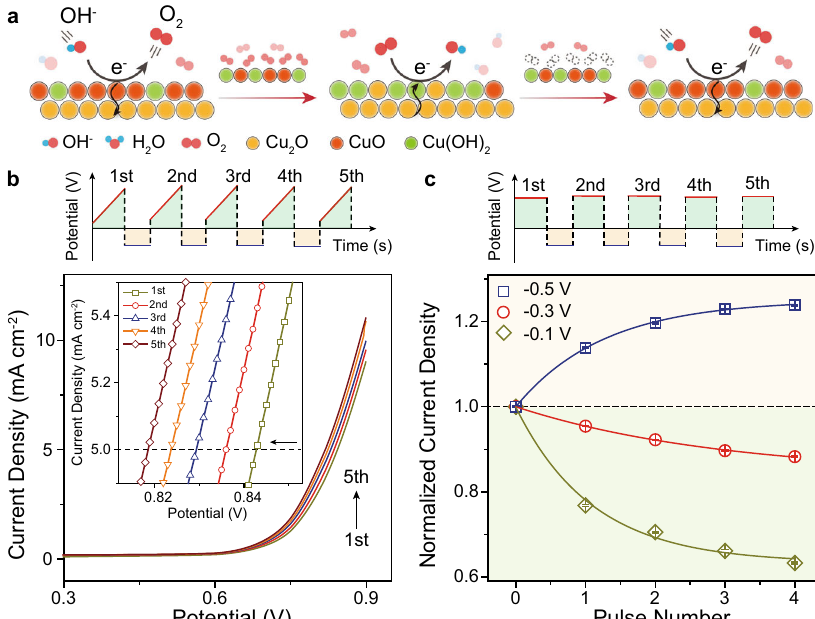
Fig. 5 Programmable potential scan strategy to eliminate accumulated interfacial dissolved oxygen at the EEIs. a Schematic illustration of reduction potential pulse accelerating interfacial oxygen species removed from the electrode surface. b Linear sweep voltammetry curves of Cu electrode combined with reduction potential multi-pulse ( − 0.50 V) in 0.10 M KOH solution at a scan rate of 0.01 V s − 1 . Inset shows cathodic shift of the oxygen evolution potential as consecutive reduction potential pulses ( − 0.50 V). c Mean chronoamperometry current density at 0.70 V as a function of reduction potential multi-pulse ( − 0.50, − 0.30, and − 0.10 V) normalized by the value of the original current density ( fi rst scan). Error bar represents the SE during consecutive fi ve scans. Schematic of the programmed potential scan strategy shown in the upper panel in b and c ,